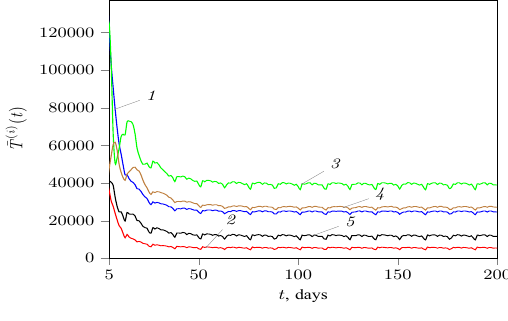
1 Figure 5. Dynamics of point estimates I ( t ) at experiment 1.